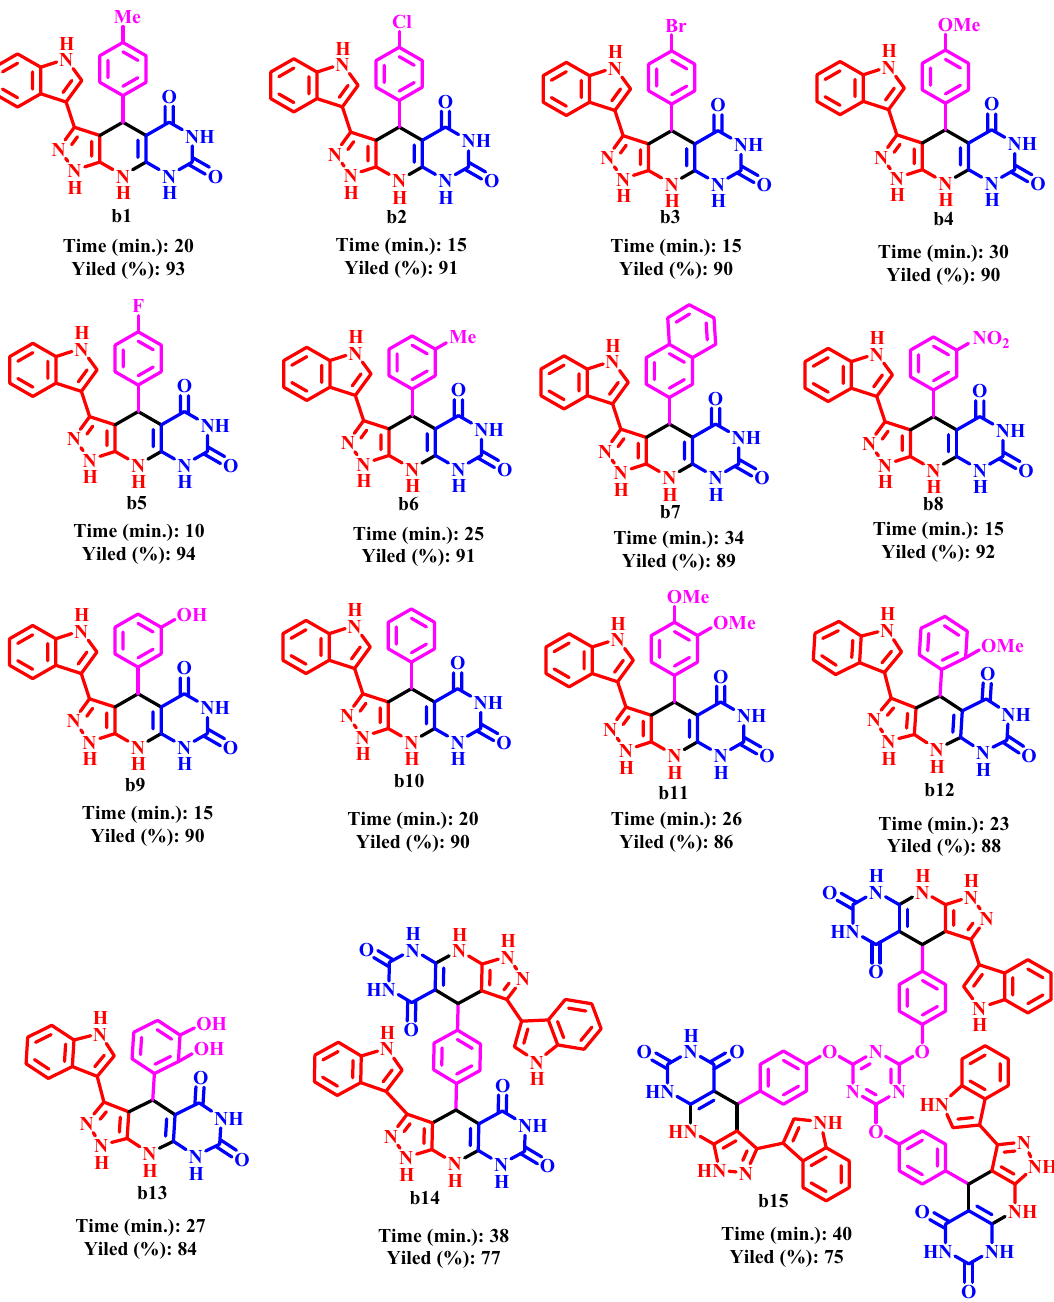
Table 2. Synthesis of pyrazolo[4 ′ ,3 ′ :5,6]pyrido[2,3- d ]pyrimidines using CQDs–N(CH 2 PO 3 H 2 ) 2 /SBA15 under solvent free